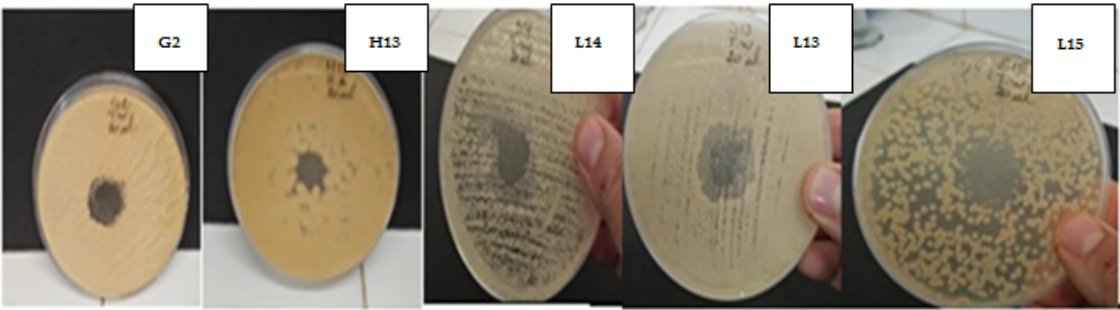
Table 9. Effect of the EO on the growth of yeasts and molds. Species